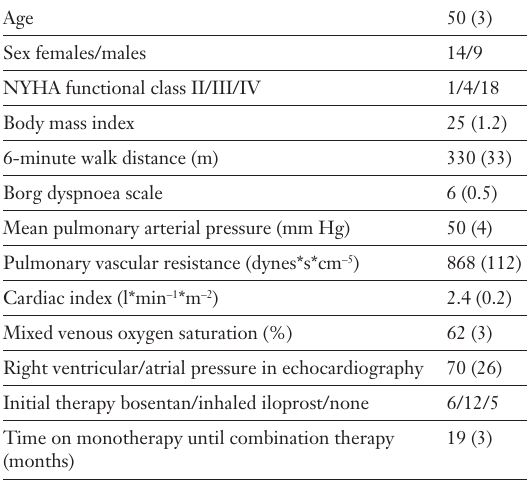
Patients’ characteris- tics and haemody- namics before onset of combination